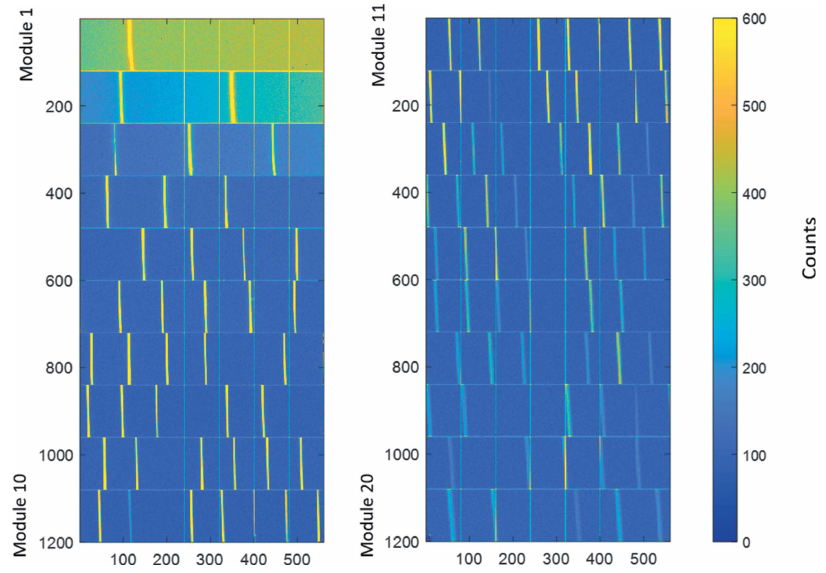
Figure 12 Image of the LaB 6 powder recorded from the CirPAD using X-ray photons of 17.94 keV (10 s acquisition time). The modules index (from 1 to 20) increases from top to bottom for each